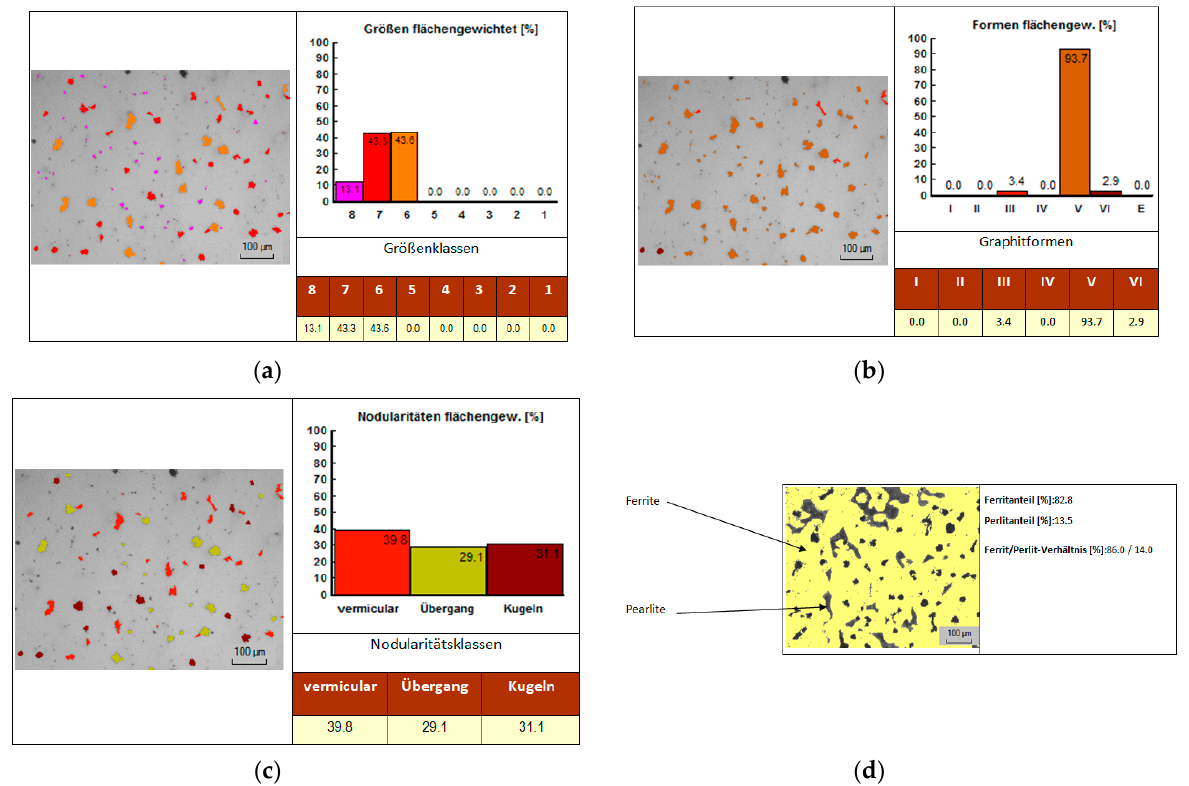
Figure 23. Graphite size analysis using AMGUSS analysis software: ( a ) Graphite size analysis using AMGUSS analysis software; ( b ) Graphite nodule shape analysis using AMGUSS analysis software; ( c ) Graphite nodularity analysis using AMGUSS analysis software; ( d ) Analysis of ferrite and pearlite concentration in the cast iron structure of type EN-GJS-400-15 using AMGUSS analysis software.